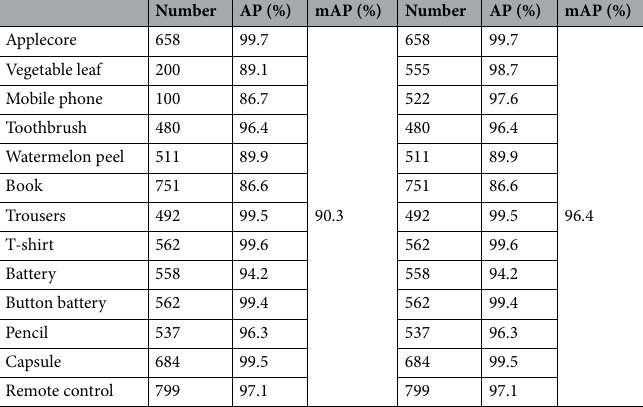
Table 12. Sample distribution imbalance model test results.